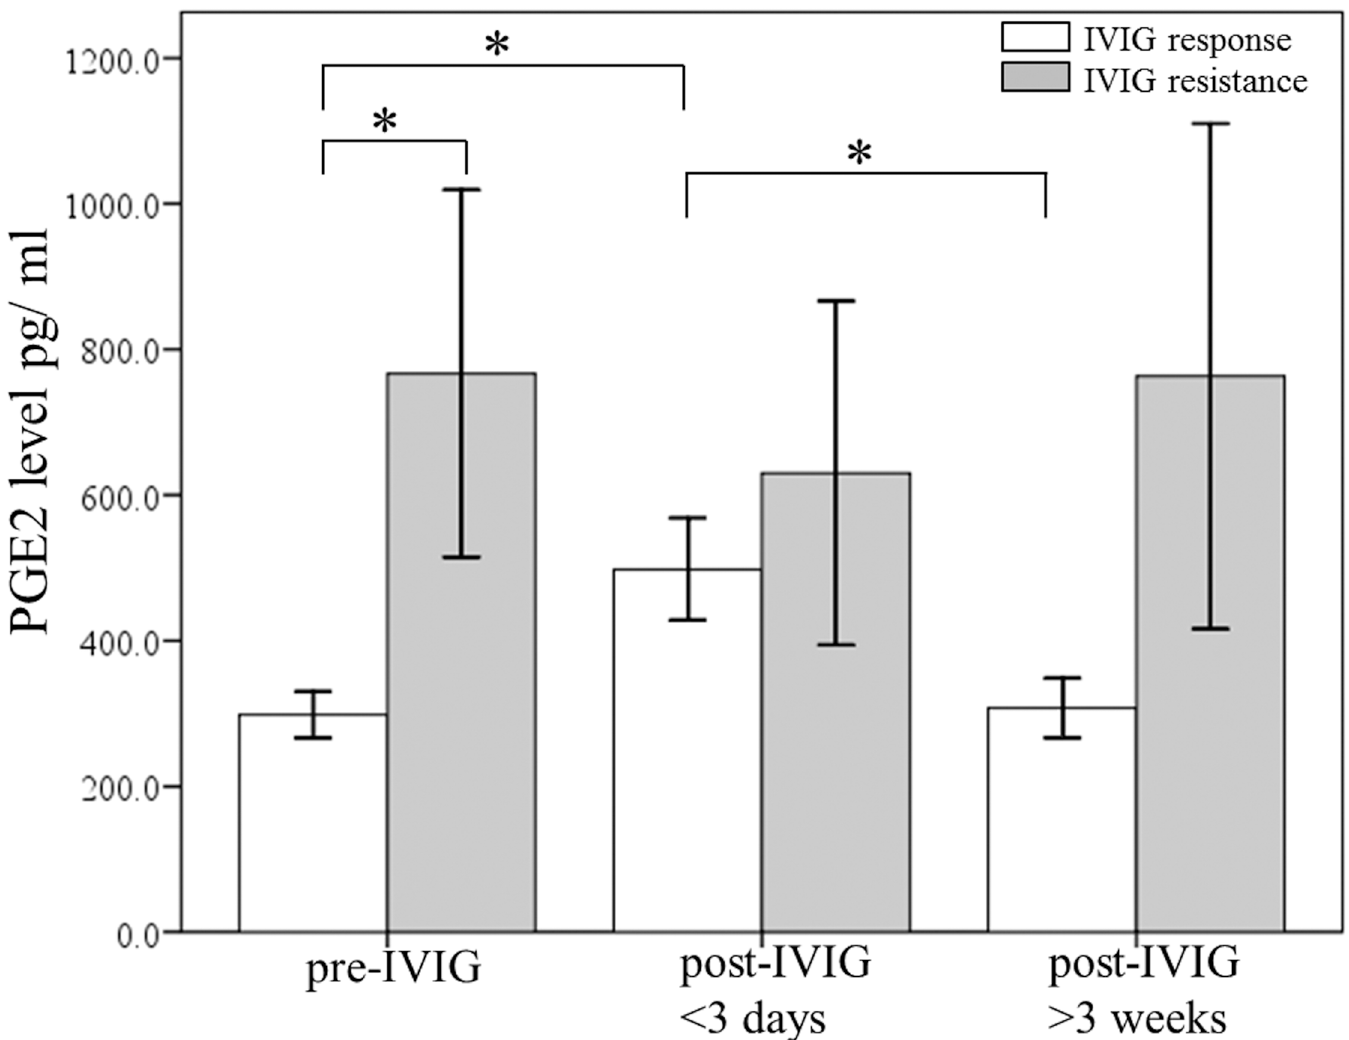
Fig 2. A comparison of plasma PGE 2 levels using ELISA between KD patients that responded to IVIG treatment (N = 130) and those that were IVIG resistant (N = 14) prior to receiving IVIG treatment and following IVIG treatment. * p < 0.05. Data are presented as mean ± standard